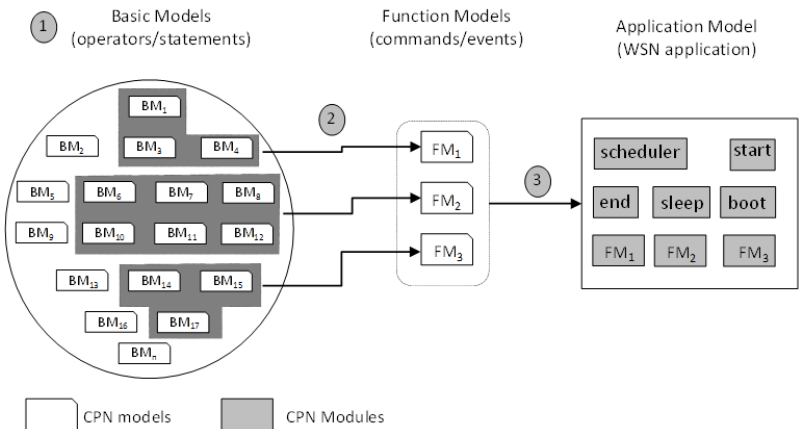
Figure 2. Schematic view of the CPN models